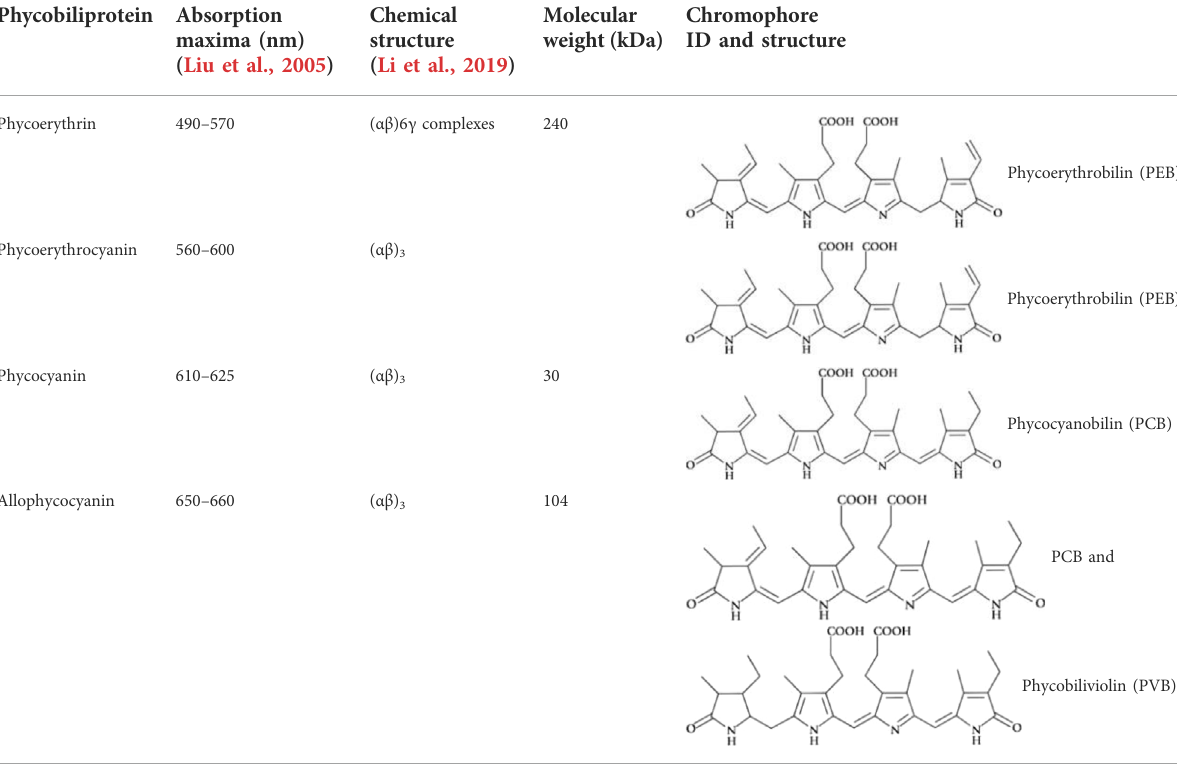
TABLE 1 Main properties and characteristics of